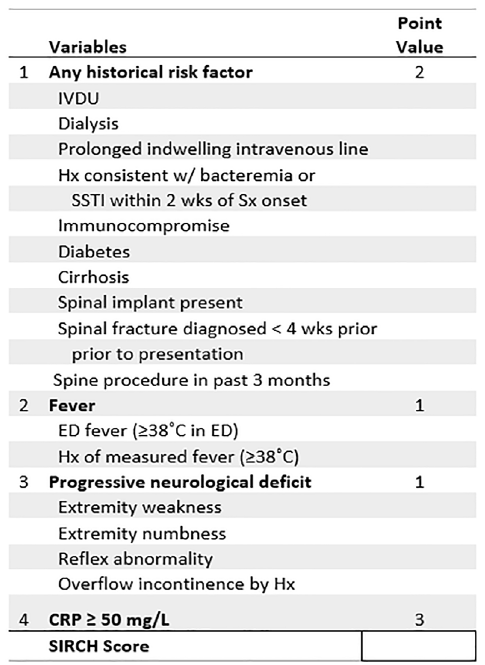
Figure 2. Calculation for spinal infection risk calculation heuristic score.